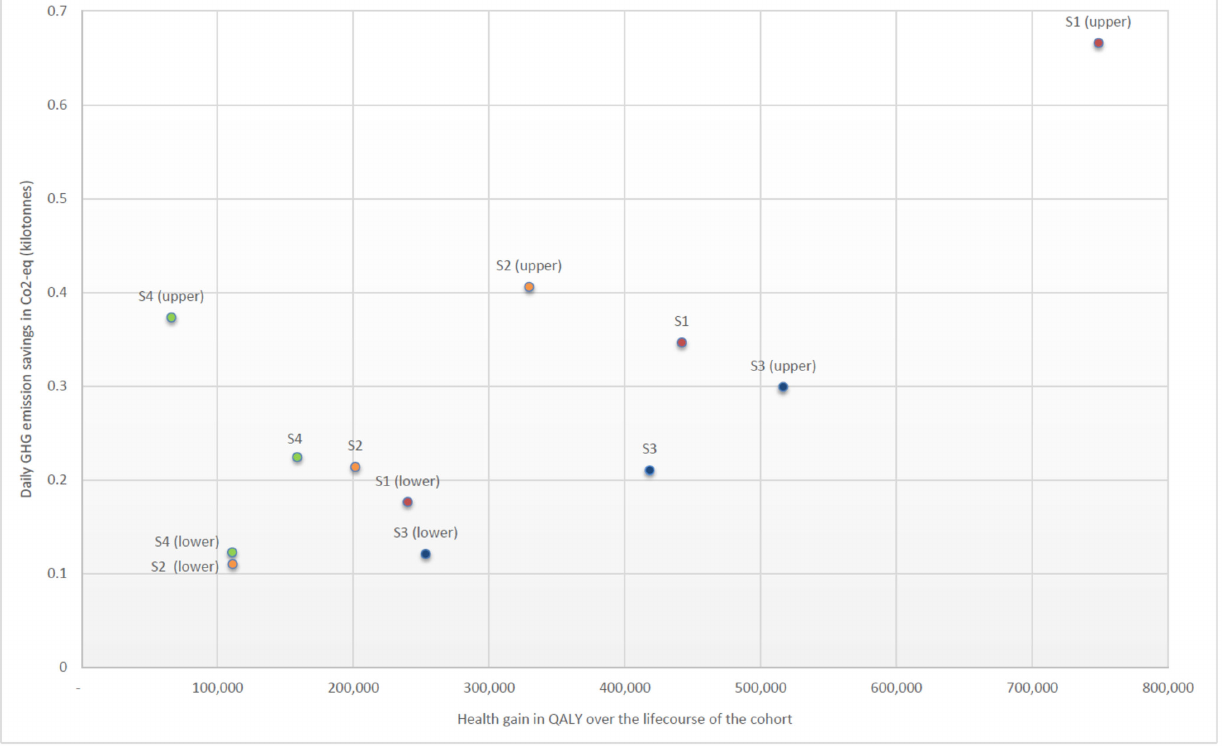
Figure 2. GHG emission impact against health impact of the four main scenarios and their upper and lower sensitivity analyses.